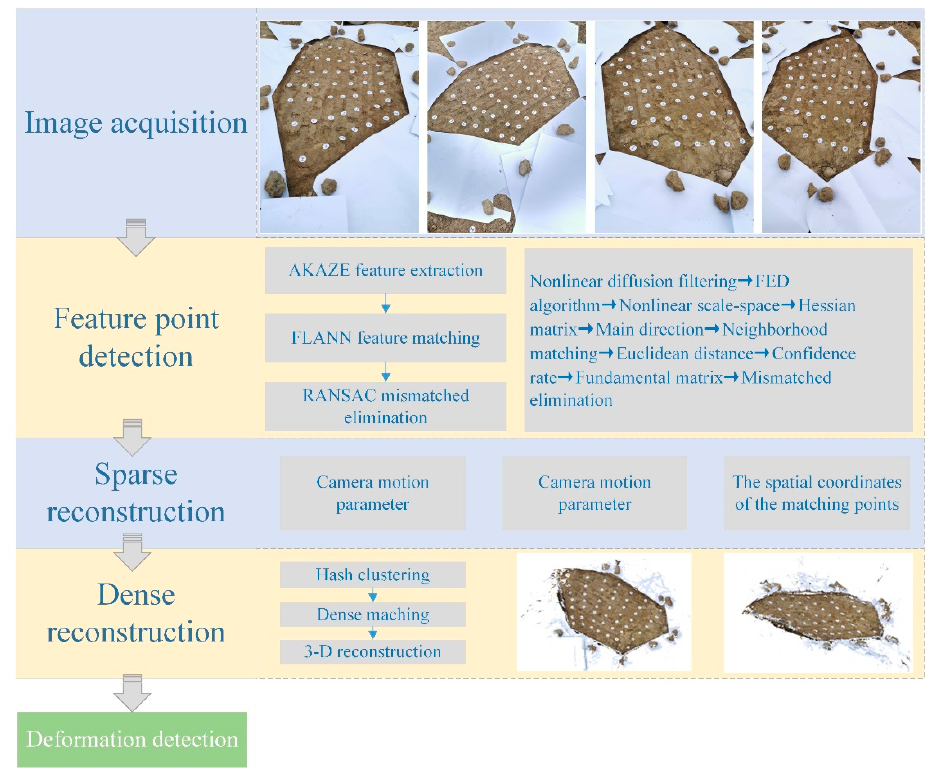
Figure 1. The framework for 3D reconstruction of rock mass surface. FED, fast explicit diffusion.